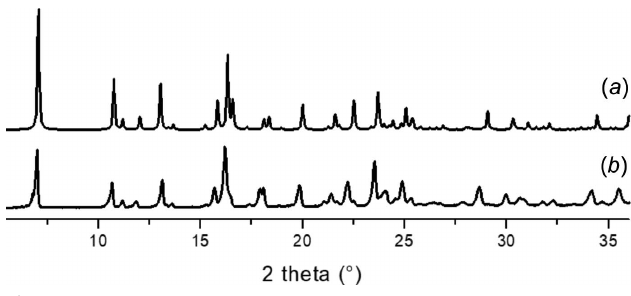
Figure 6 PXRD patterns ( a ) simulated from the single-crystal data of 1 and ( b ) measured from a sample of 1 prepared from 2,6-H 2 NDC and Zn(OAc) 2 in DEF containing formic